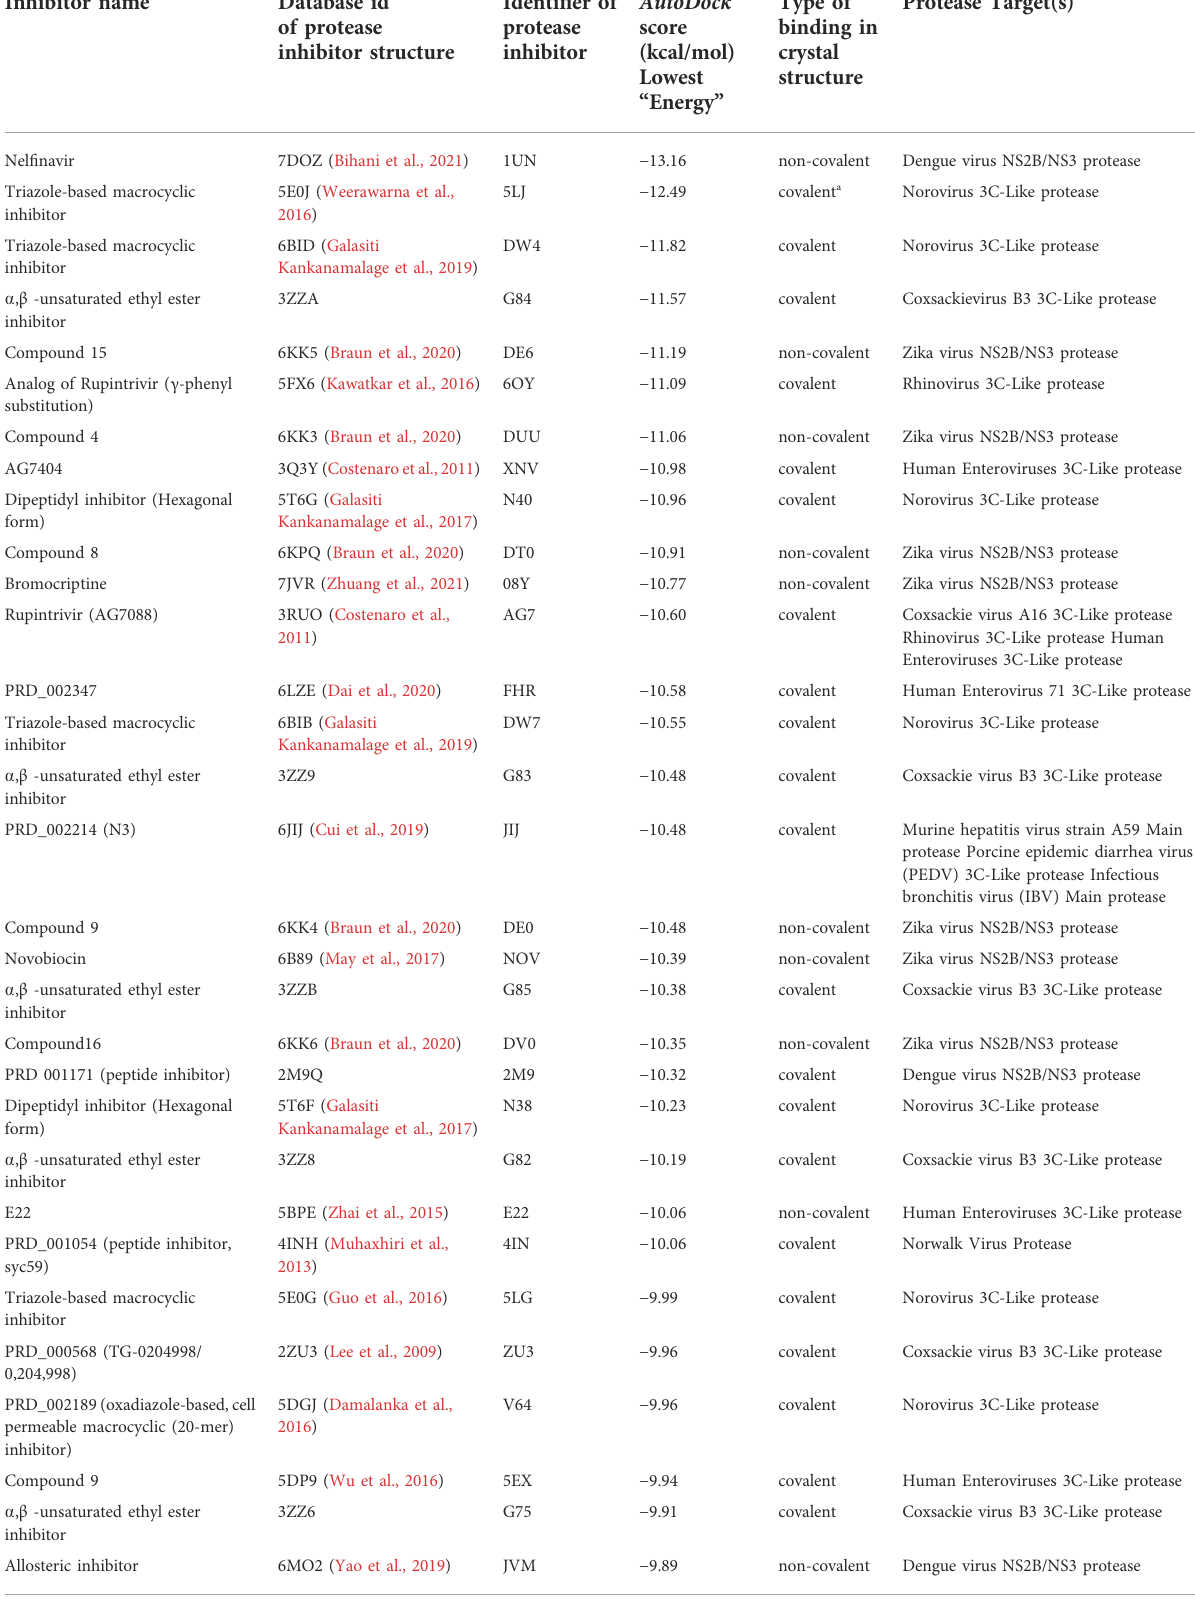
TABLE 3 Docking scores for viral protease inhibitors with SARS-CoV2 3CL pr . o